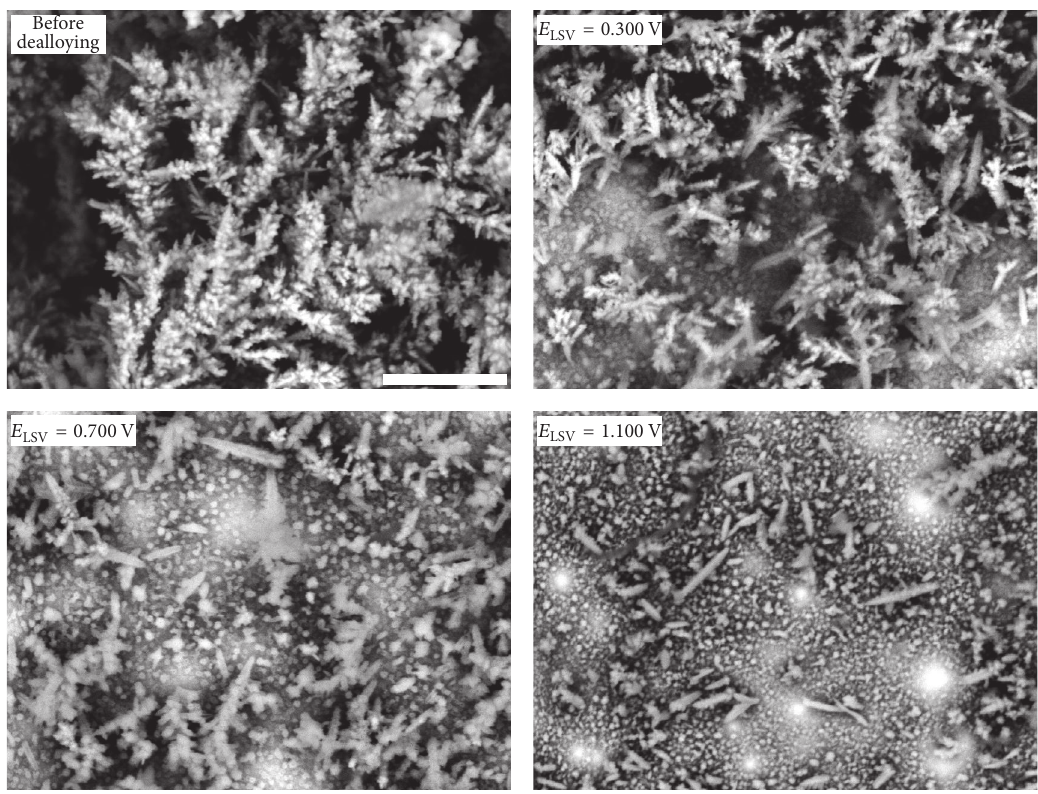
Figure 10: SEM images of samples from the low Ni percentage NiCoCu samples (Set D) before dealloying and after different dealloying steps. The scale bar is 5 𝜇 m for all the